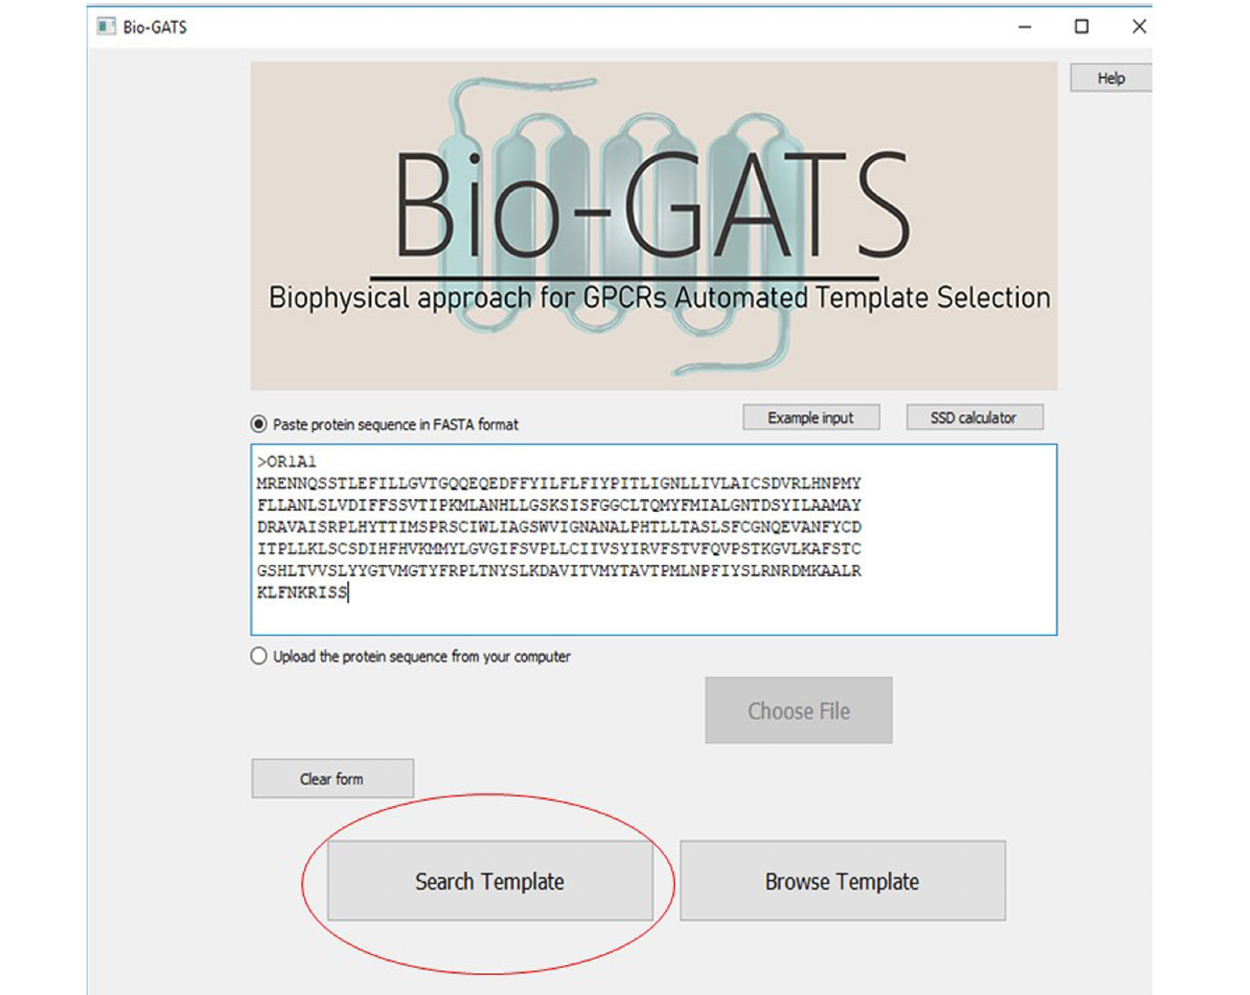
Frontiers in Molecular Biosciences |